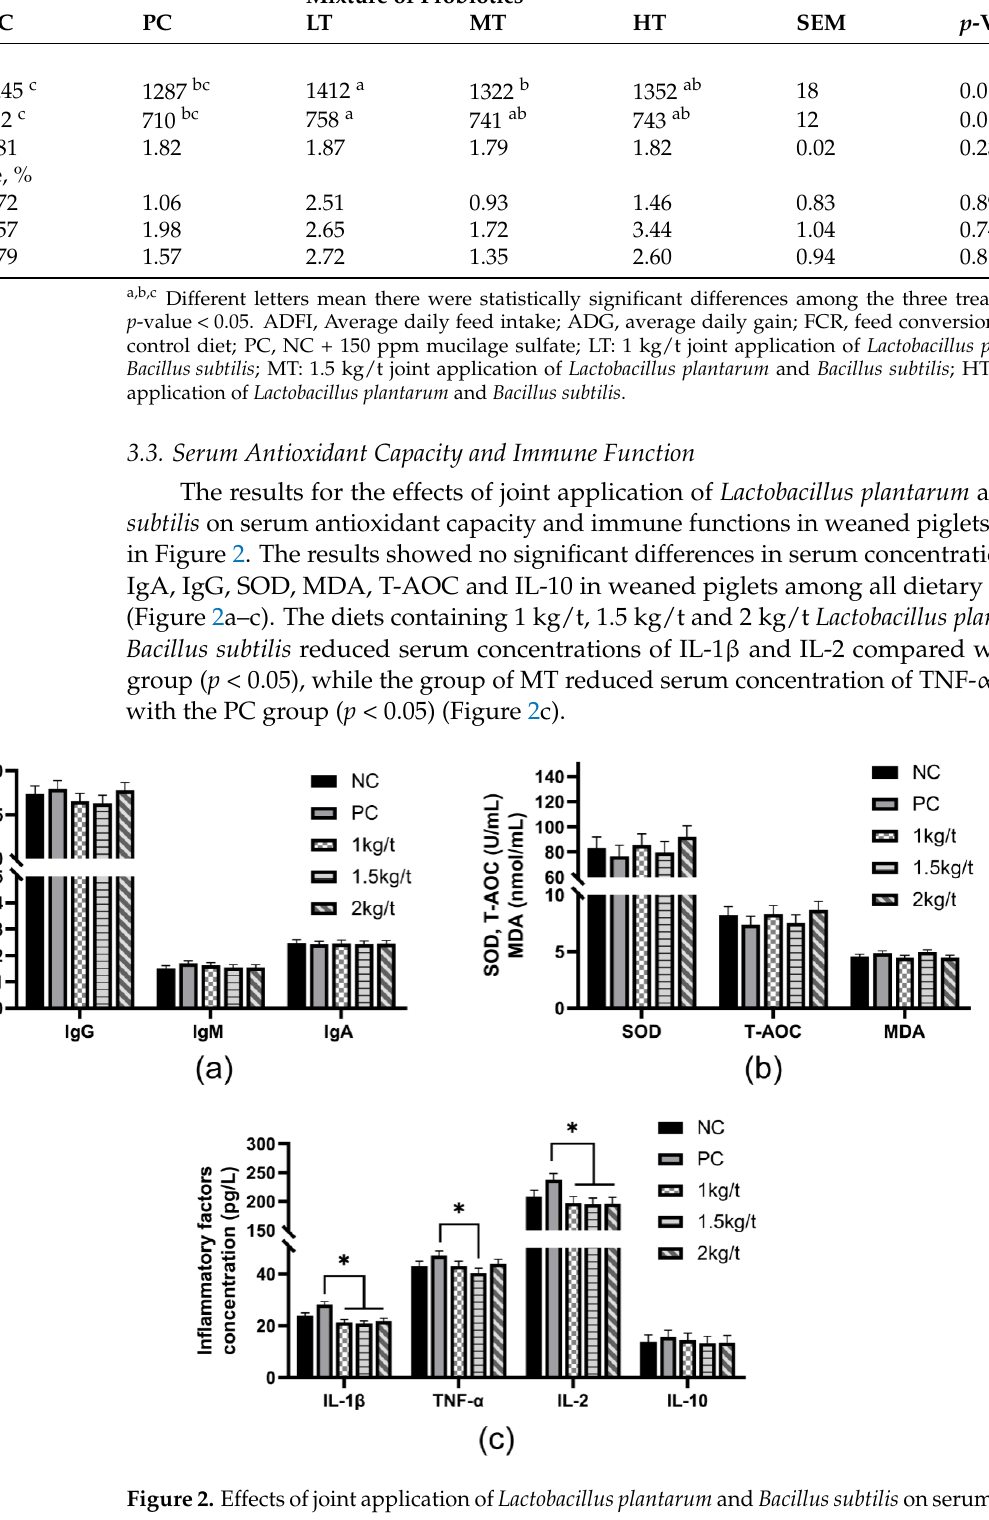
Mixture of Probiotics